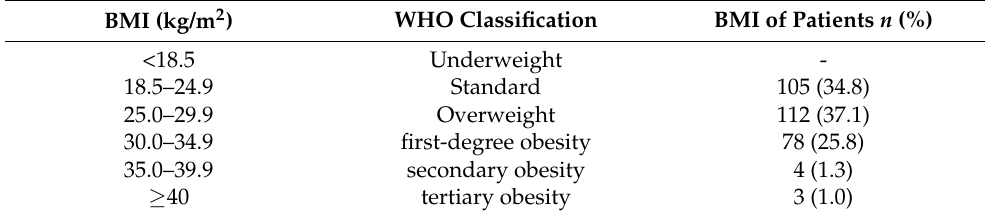
Table 3. WHO classification of patients’ BMI